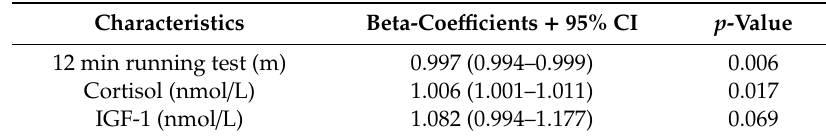
Table 4. Prediction model for dropout (Cox proportional hazards regressions) including all variables in the same model after using STEP algorithm to reduce variables that are not expected to improve